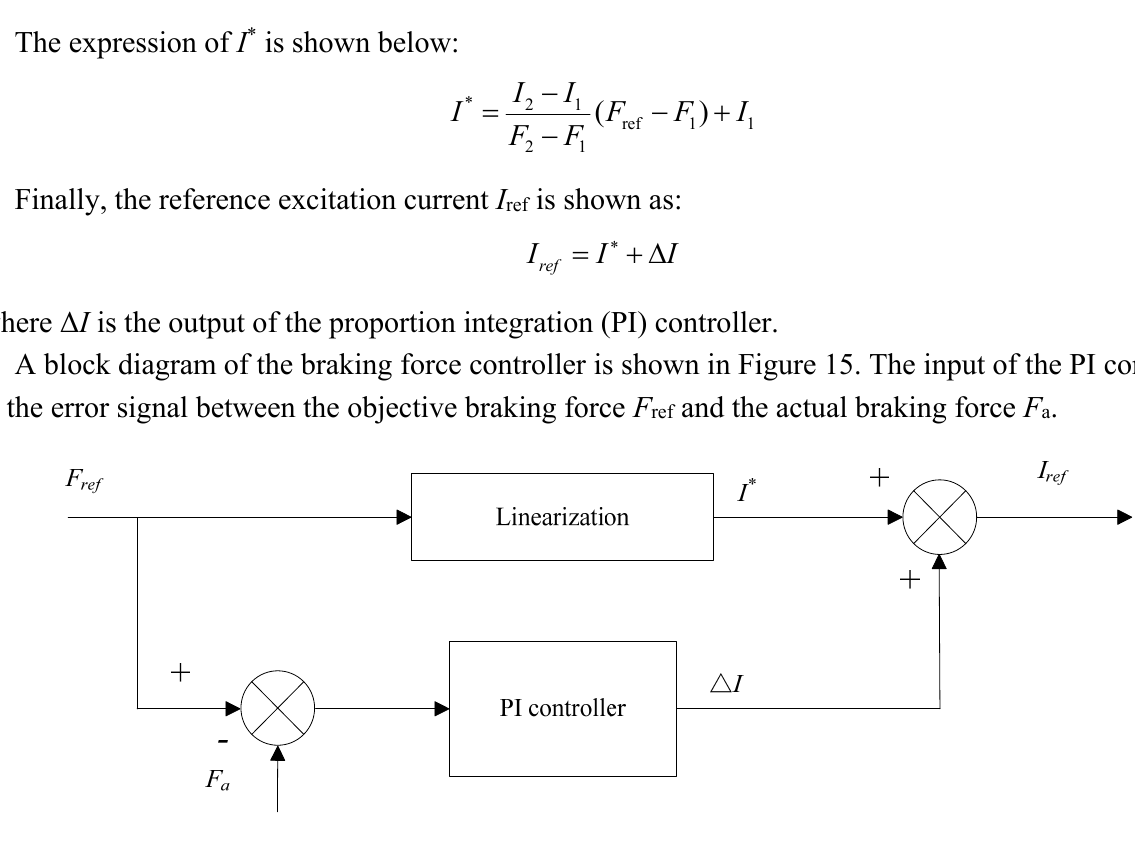
Figure 14. Schematic diagram of piecewise linearization.